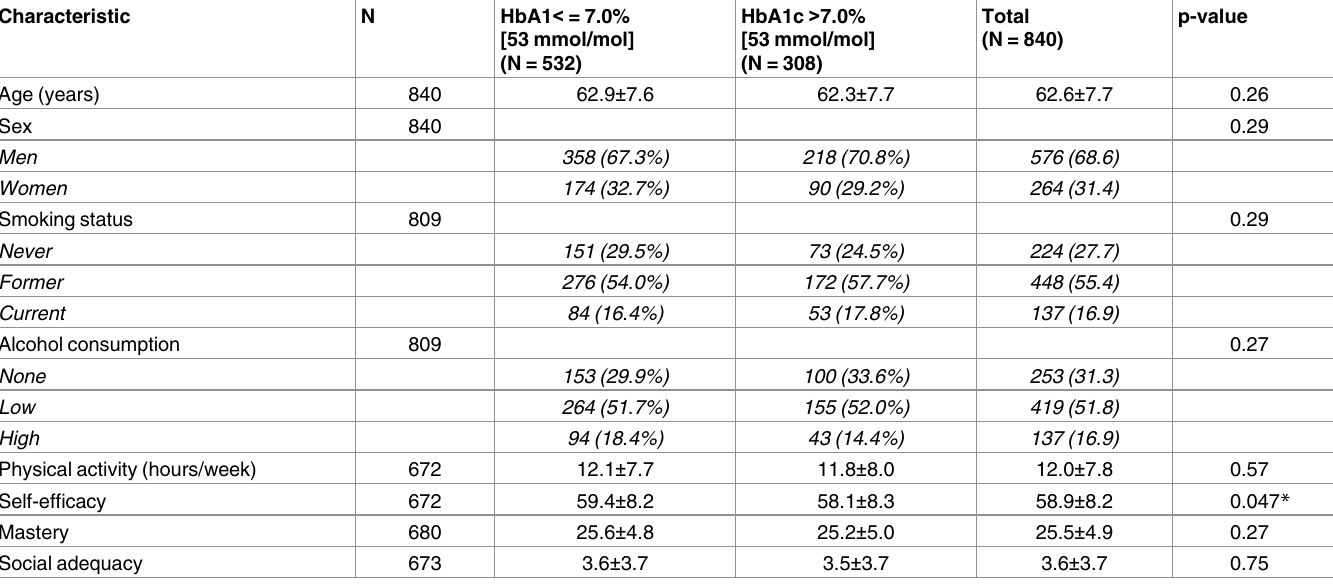
Table 1. Person-related patient characteristics by glycaemic